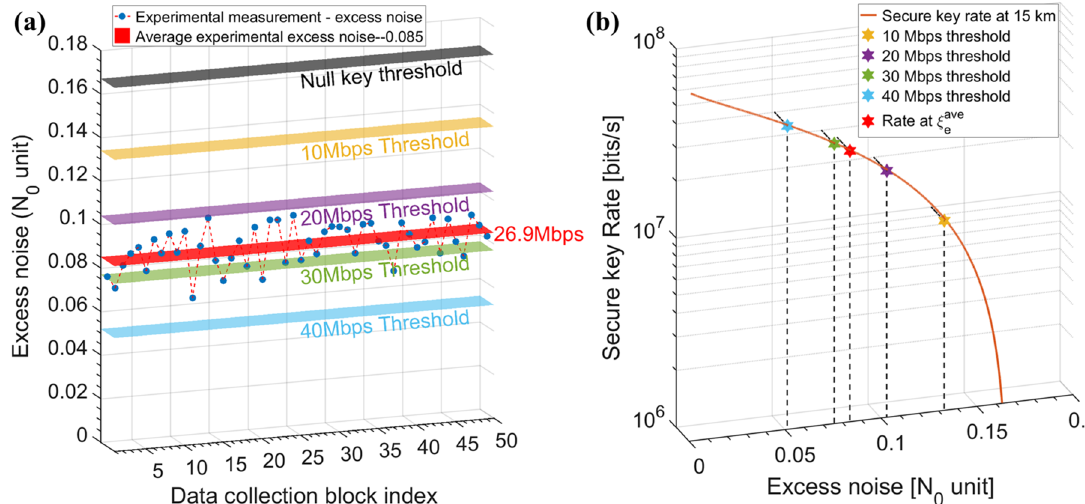
Figure 4. Excess noise stability in our LLO CVQKD system. ( a ) Experimental measurement of excess noise. The blue dots represent the collected excess noise at each data block and the red surface is their average value. Surfaces with different colours are theoretical secure key rate thresholds for null key, 10 Mb/s, 20 Mb/s, 30 Mb/s and 40 Mb/s secret key rates. ( b ) Secure key rate with respect to different excess noises where L = 15 km and f rep = 500 MHz. The stars denote the secure key rates at different excess noise thresholds shown in Fig. 4a and the red star represents the secure key rate with an average measured excess noise ξ ave e =0.085.